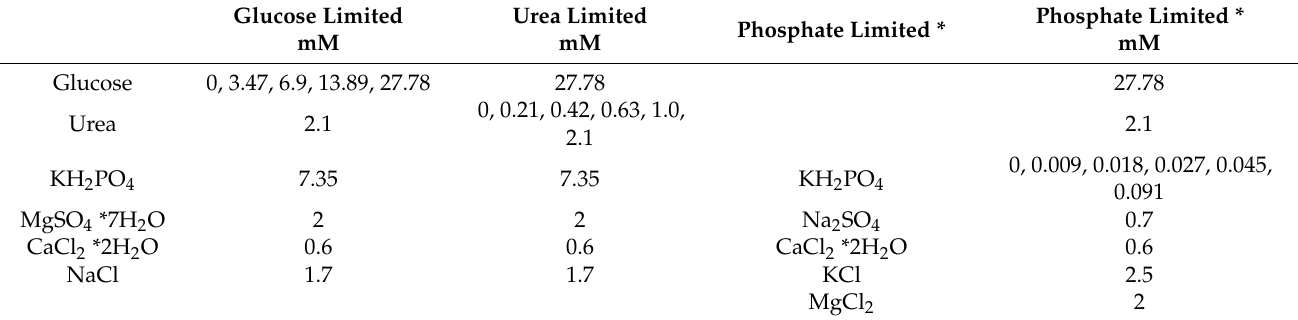
Table 1. Media concentration for micro-cultivation